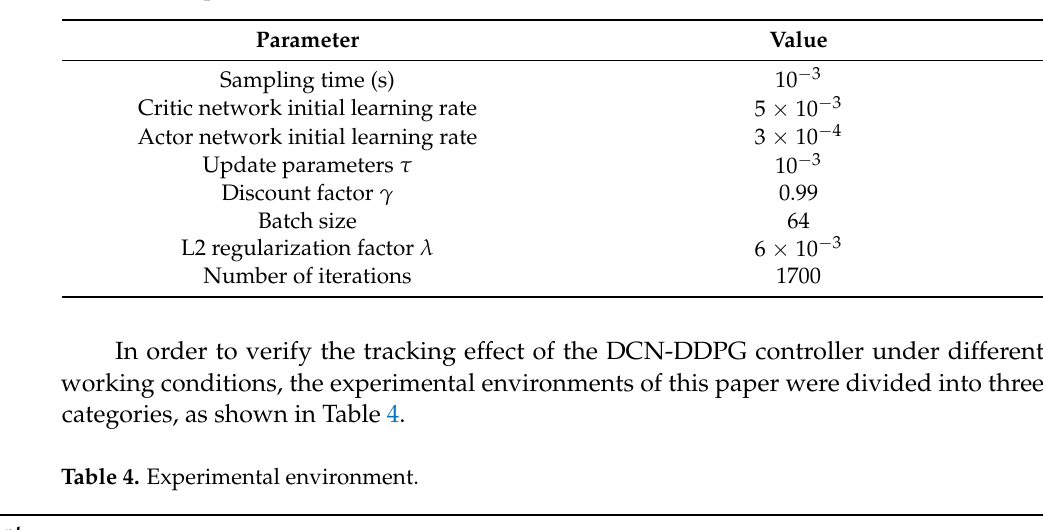
Table 3. Main parameters of DCN-DDPG.